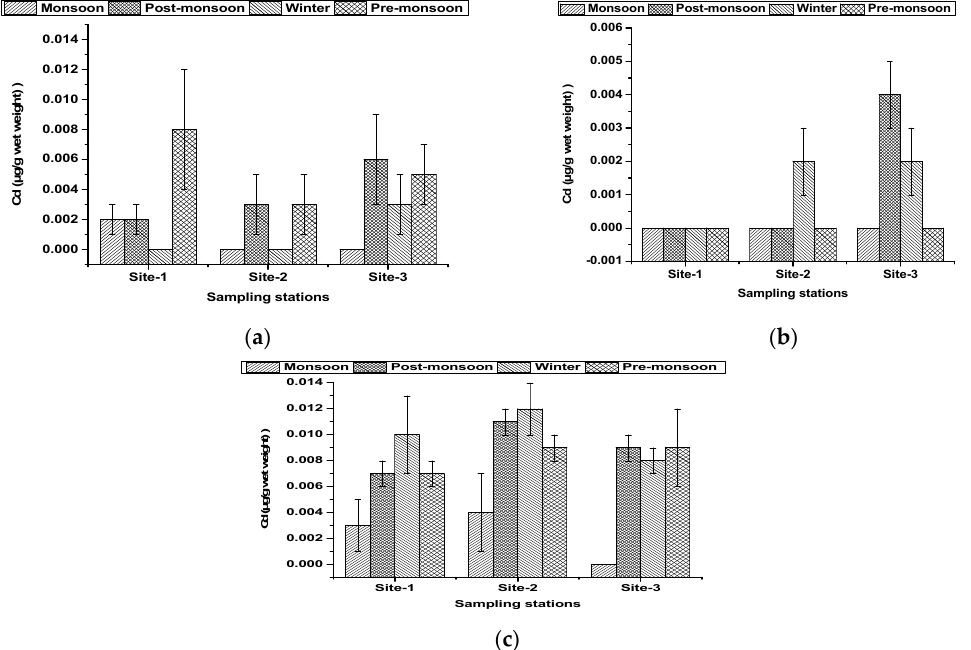
Figure 4. ( a ) Concentrations of Cadmium (Cd) in L. rohita fish species; ( b ) Concentrations of Cadmium (Cd) in C. cirrhosus fish species; ( c ) Concentrations of Cadmium (Cd) in L. calbasu fish species.